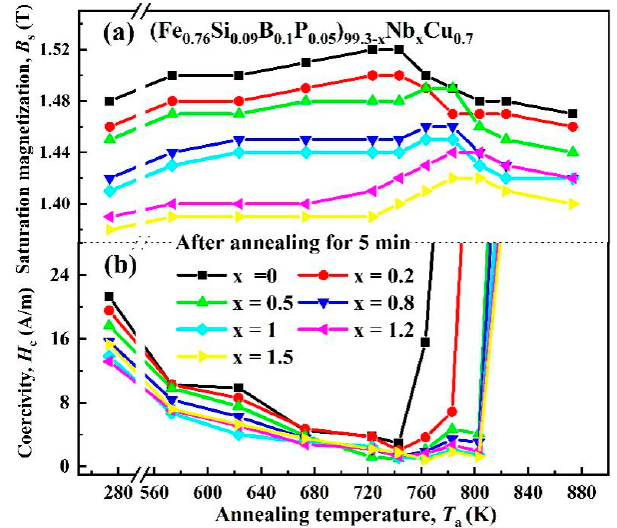
Figure 6. ( a ) B s and ( b ) H c of (Fe 0.76 Si 0.09 B 0.1 P 0.05 ) 99.3 − x Nb x Cu 0.7 ( x = 0–1.5) ribbons dependences on T a annealed for 5